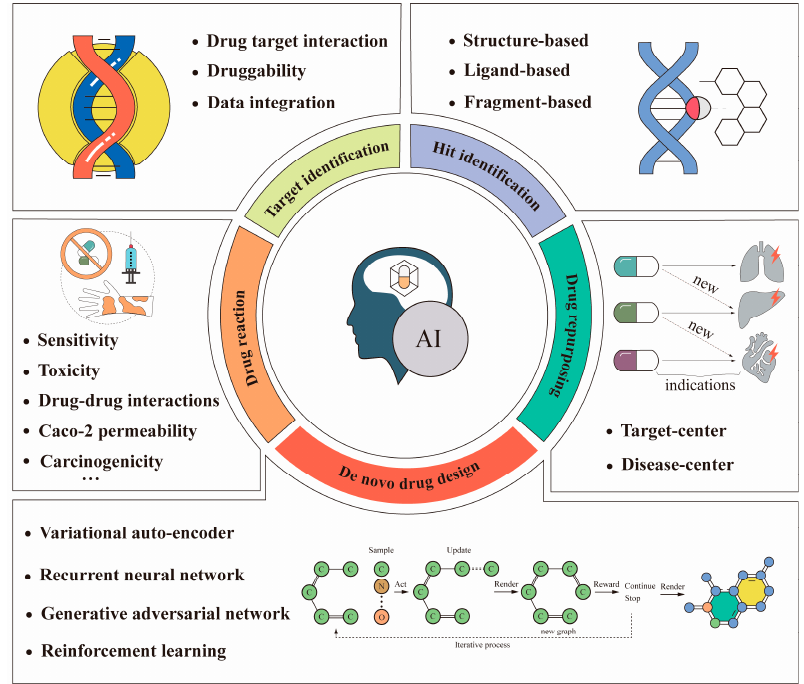
Figure 1. Some applications of artificial intelligence in anti-cancer drug design. The bottom (de novo drug design) is usually implemented using the deep learning-based models listed above. Recently, reinforcement learning has been used often. The above workflow example of a graphical chemical structure with an O–C–O connection is an iterative chemical graph generation process